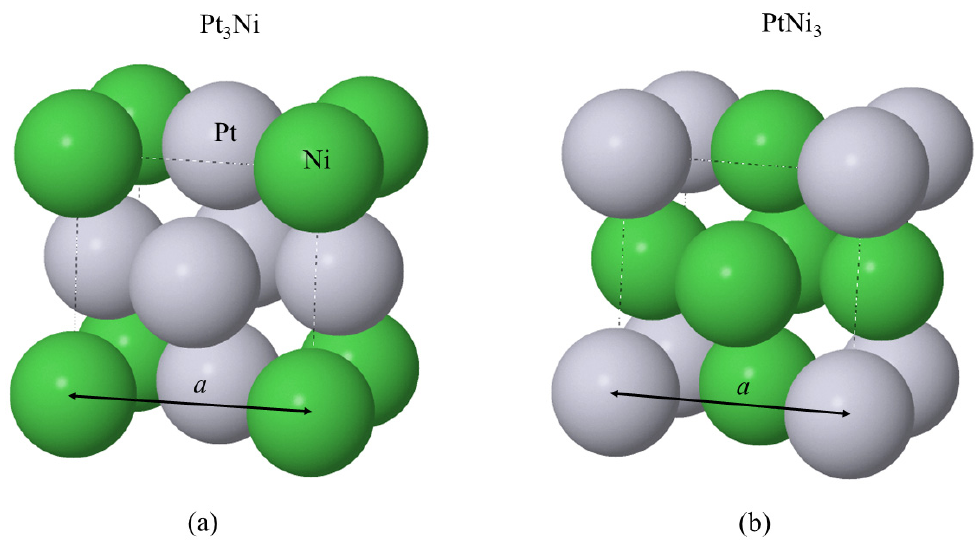
Figure 11. Orthogonal unit cell of the bulk ( a ) Pt 3 Ni and ( b ) PtNi 3 (L1 2 ) structures. The lattice parameter a for both alloys is shown by the solid arrows. Dashed lines are the edges of the orthogonal unit cell. The Pt (Ni) atoms are shown as grey (green) spheres.